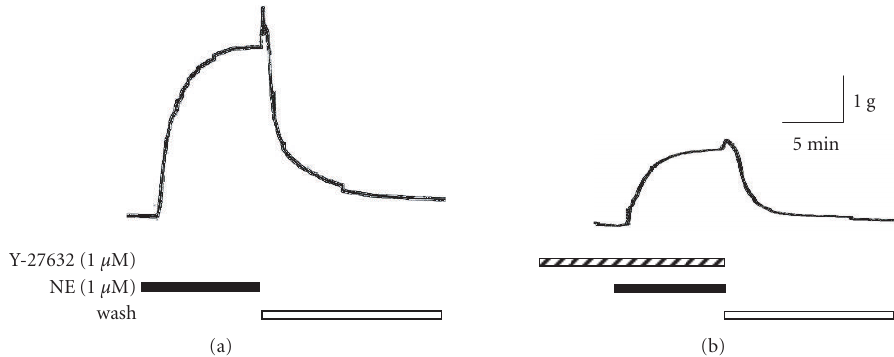
Figure 5: Inhibition of protein phosphatase PP2A potentiates AngII-induced phosphorylation of CF. Canine PASMCs were incubated with microcystin LF (MCLF, 20 nM) for 1 hour prior to 5minutes incubations with angiotensin II (AngII, 1mM) and 5-hydroxytryptamine (5- HT, 1 mM). Total protein was resolved by SDS-PAGE and then transferred onto nitrocellulose. Membranes were probed simultaneously with CF and P-CF antibodies. Immunoreactive bands of P-CF (a) were normalized to immunoreactive bands of CF (b) and the agonist-induced changes in the P-CF/CF ratio were presented as percentage of the ratio in untreated controls (Ctr, bar graphs). Mean ± SD, ( ∗ ) P < . 05 compared to untreated controls, n =